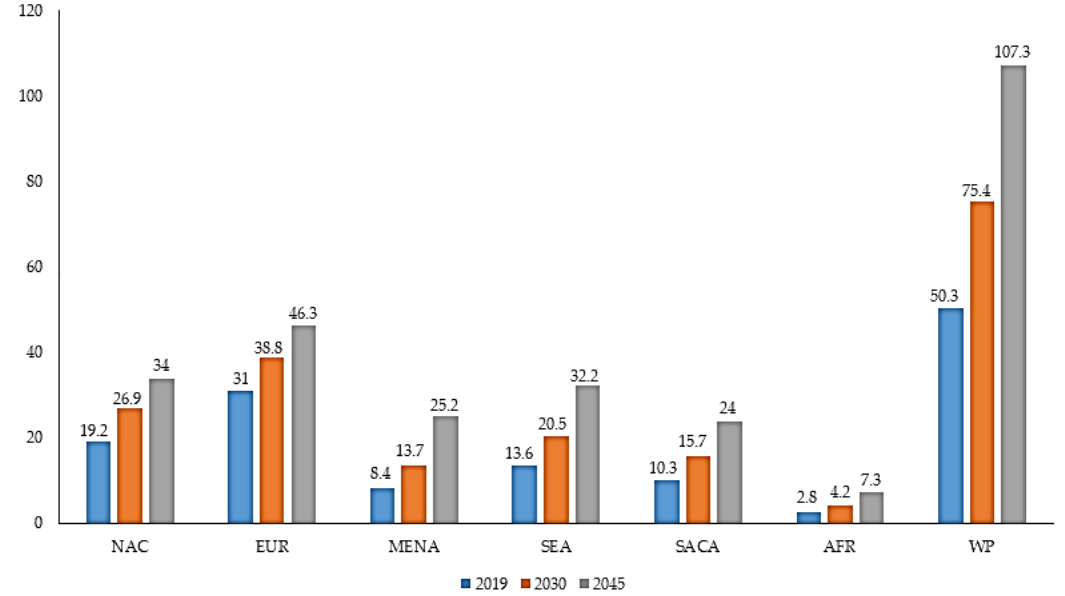
Figure 1. Prevalence of DM (millions) by IDF regions in adults ( > 65 years) in 2019, 2030 and 2045 [3]. IDF: International Diabetes Federation; NAC: North America and Caribbean; EUR: Europe; MENA: Middle East and North Africa; SEA: South-East Asia; SACA: South and Central America; AFR: Africa; WP: Western Pacific.